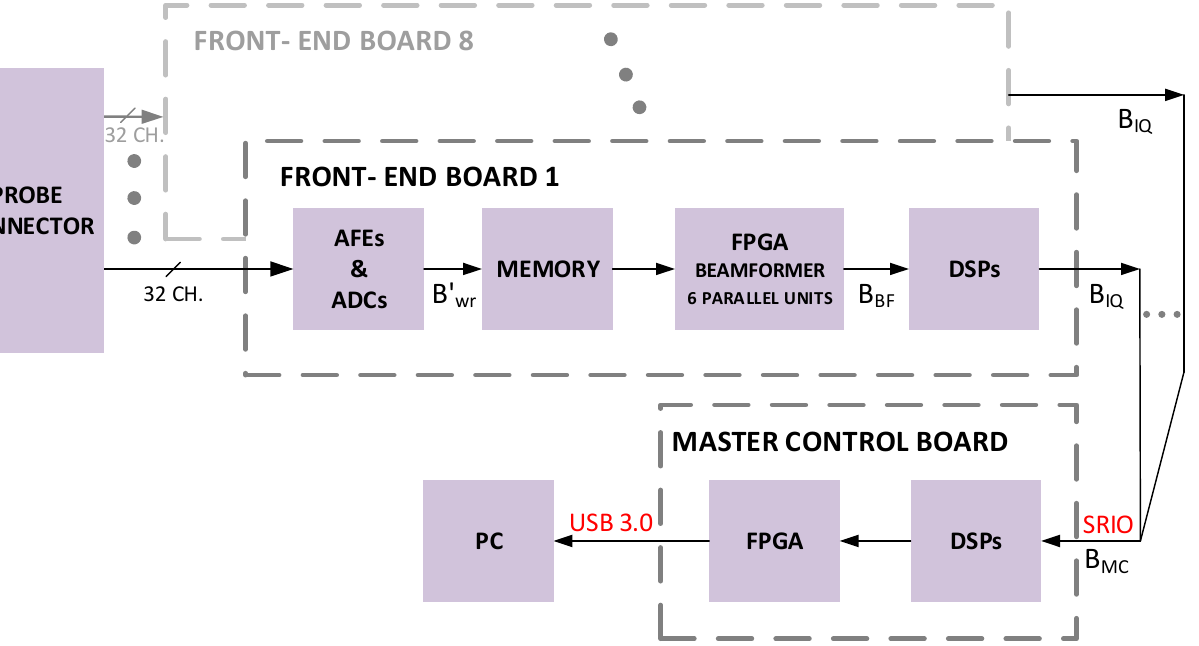
Figure 1. Architecture of the research scanner ULA-OP 256. Blocks of 32 echo data are conditioned and partially beamformed by NFE FE boards before being sent to the MC board. B ’wr represents the write data transfer bandwidth required to the FE memory to save the 32 channels echo data.